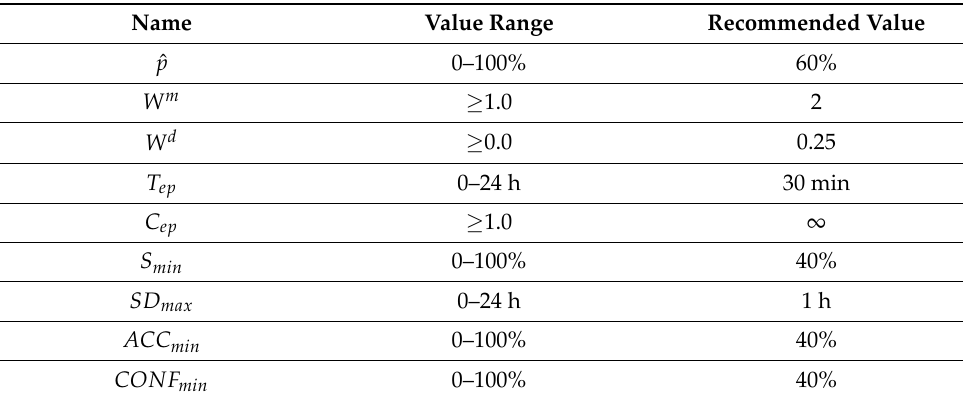
Table 3. Overview of the parameters of the proposed